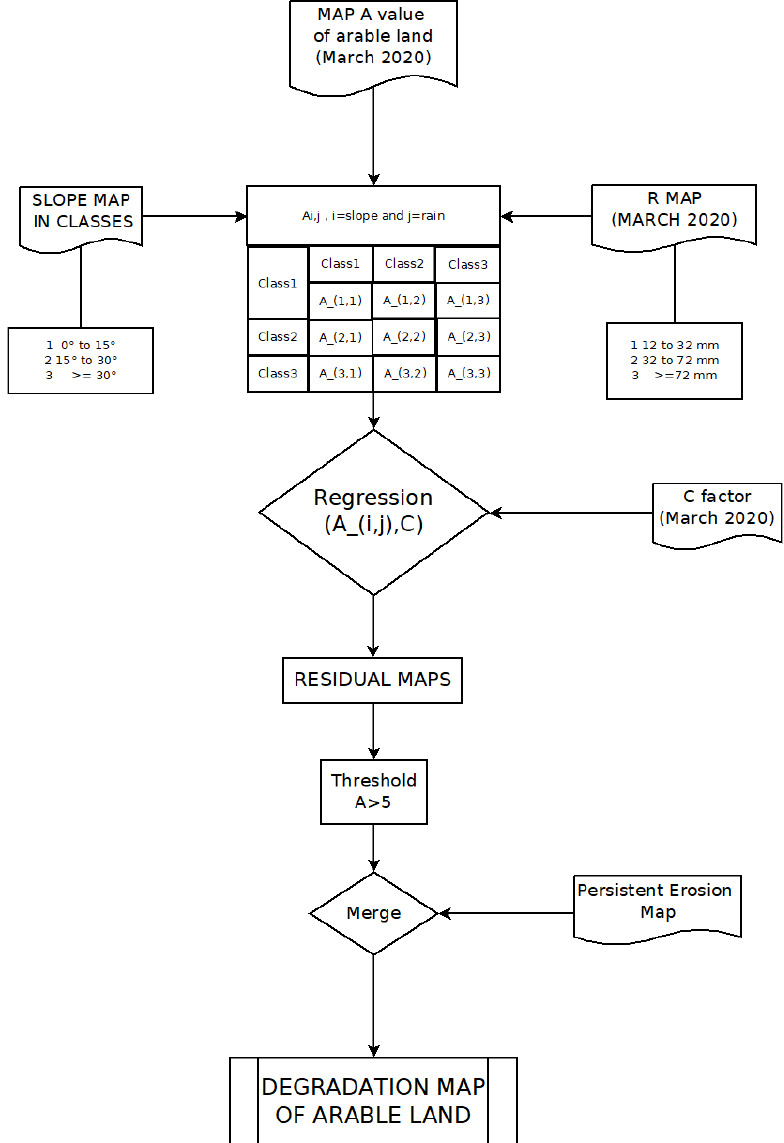
Figure 2. Flow chart for the elaboration of a degradation map of rural